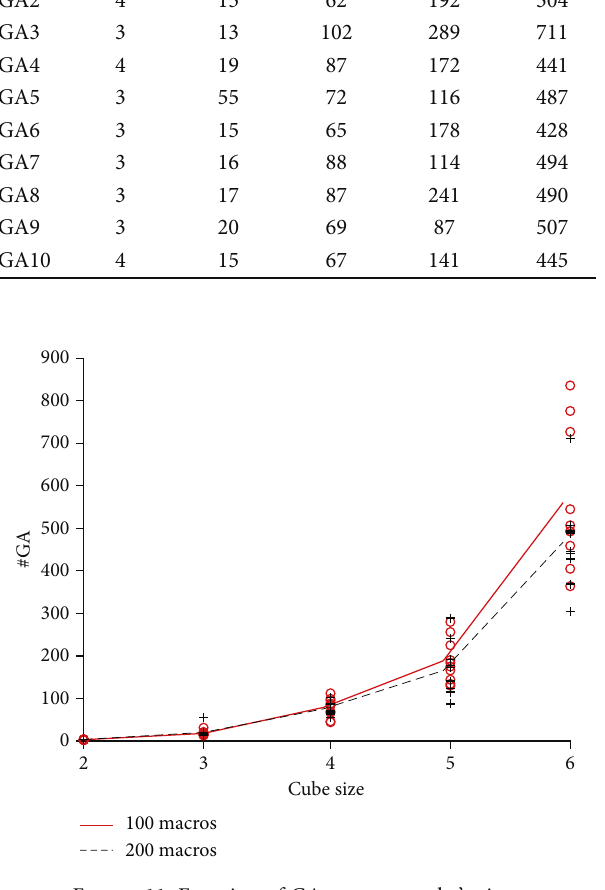
Figure 11: Function of GA count vs. cube ’ s size. Table 5: Calculation time (s) with 100 macros.